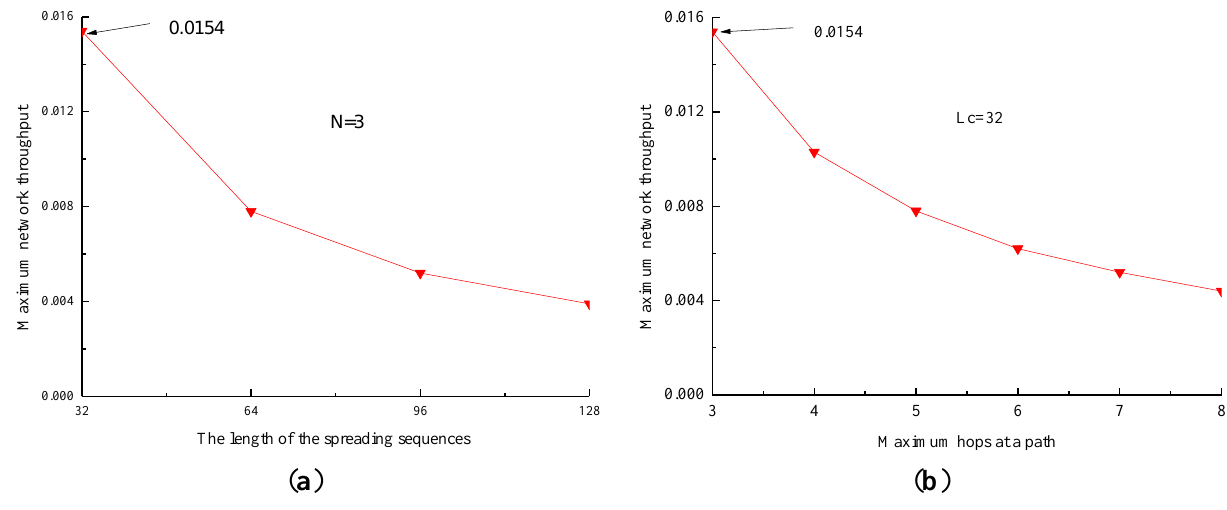
Figure 8. The impact of the length of the spreading sequences and the number of hops at a path on the maximum network throughput of the proposed protocol. ( a ) The length of the spreading sequences; ( b ) The number of hops at a